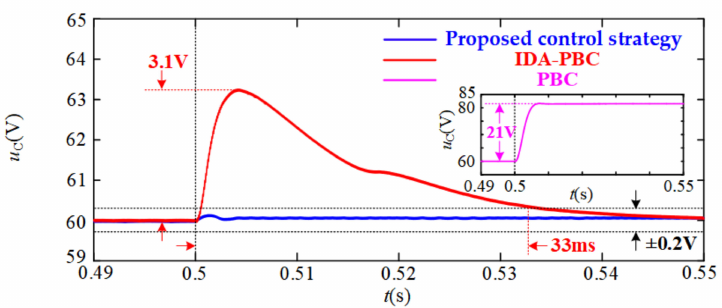
Figure 12. The simulation results of the different control strategies under input voltage